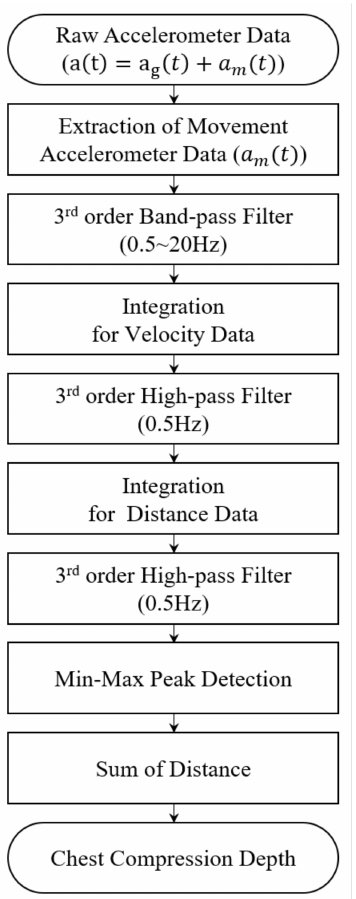
Figure 2. Flow chart of the chest compression depth estimation